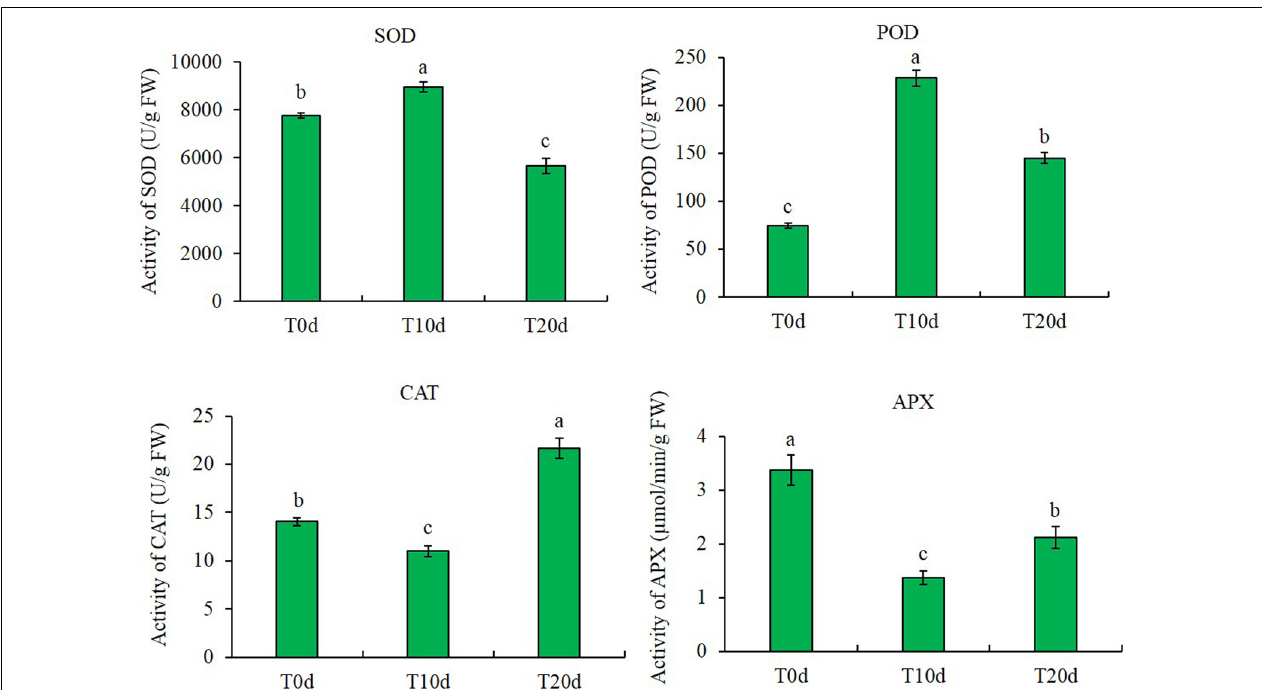
FIGURE 1 | Changes in enzyme activity in different waterlogging treatments. Columns with the same letter were not significantly different at p < 0.05.